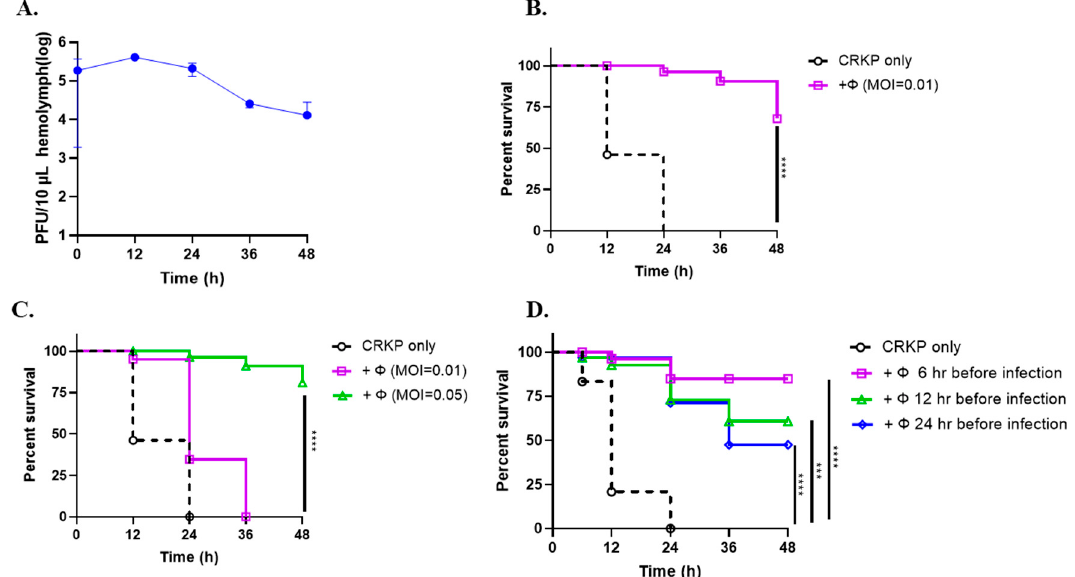
Figure 5. Phage SRD2021 therapy in G. mellonella model. ( A ) Bacteriophage persistence in G. mellonella larvae. Larvae were injected with 10 µ L of phage (10 8 PFU/mL) in SM buffer. Equal 10 µ L of hemolymph was collected from worms at 12-h intervals,